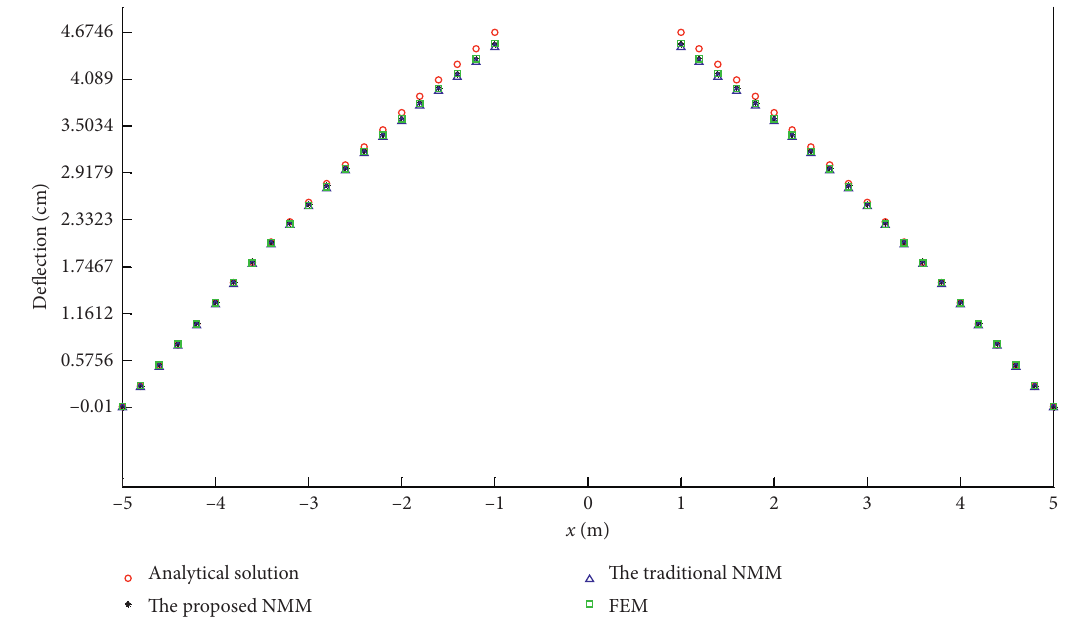
Figure 15: Deflection comparisons of a simply supported annular plate under a distributed load calculated with different